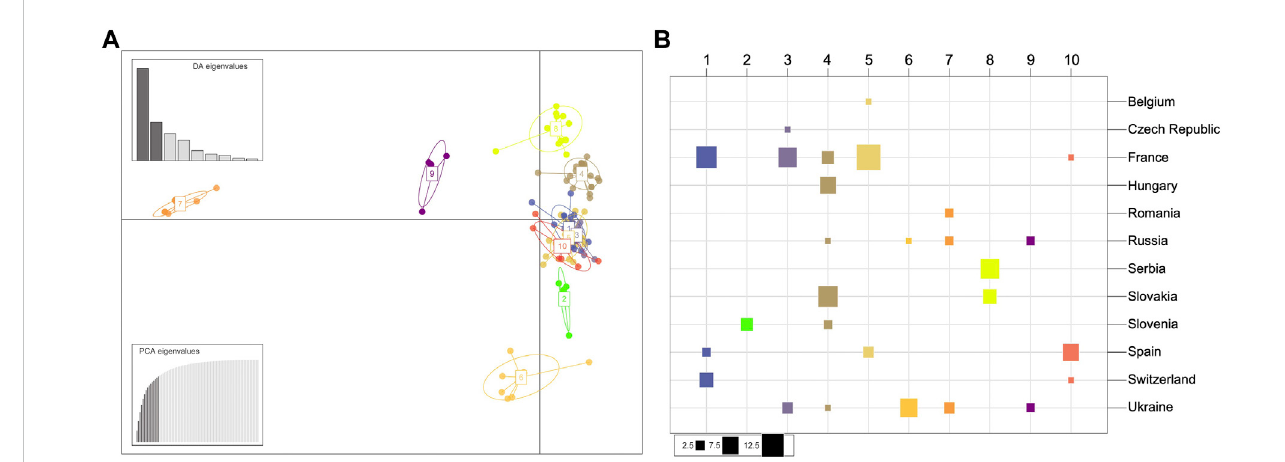
FIGURE 4 Population structure of theEuropean Dothistroma pini collection of isolates. (A) Scatterplot ofthe discriminant analysisof principal components (DAPC) on European Dothistroma pini multilocus haplotypes. The number and colours represent the 10 groups delineated by the K-means method. Individual multilocushaplotypesarerepresentedbydotsandclustersasellipses.Atthetoplefttheeigenvaluesofthe fi rstnineaxesarerepresented. (B) Thecomposition of the DAPC clusters. The columns and colours correspond to the inferred clusters and the rows correspond to the countries where the populations weresampled.Thesizeofthesquaresisproportionaltothenumberofindividualscomprisingeachcluster.Clusteroneforinstanceiscomprisedofindividuals isolated from France, Spain and Switzerland with the majority of the individuals in this cluster isolated from